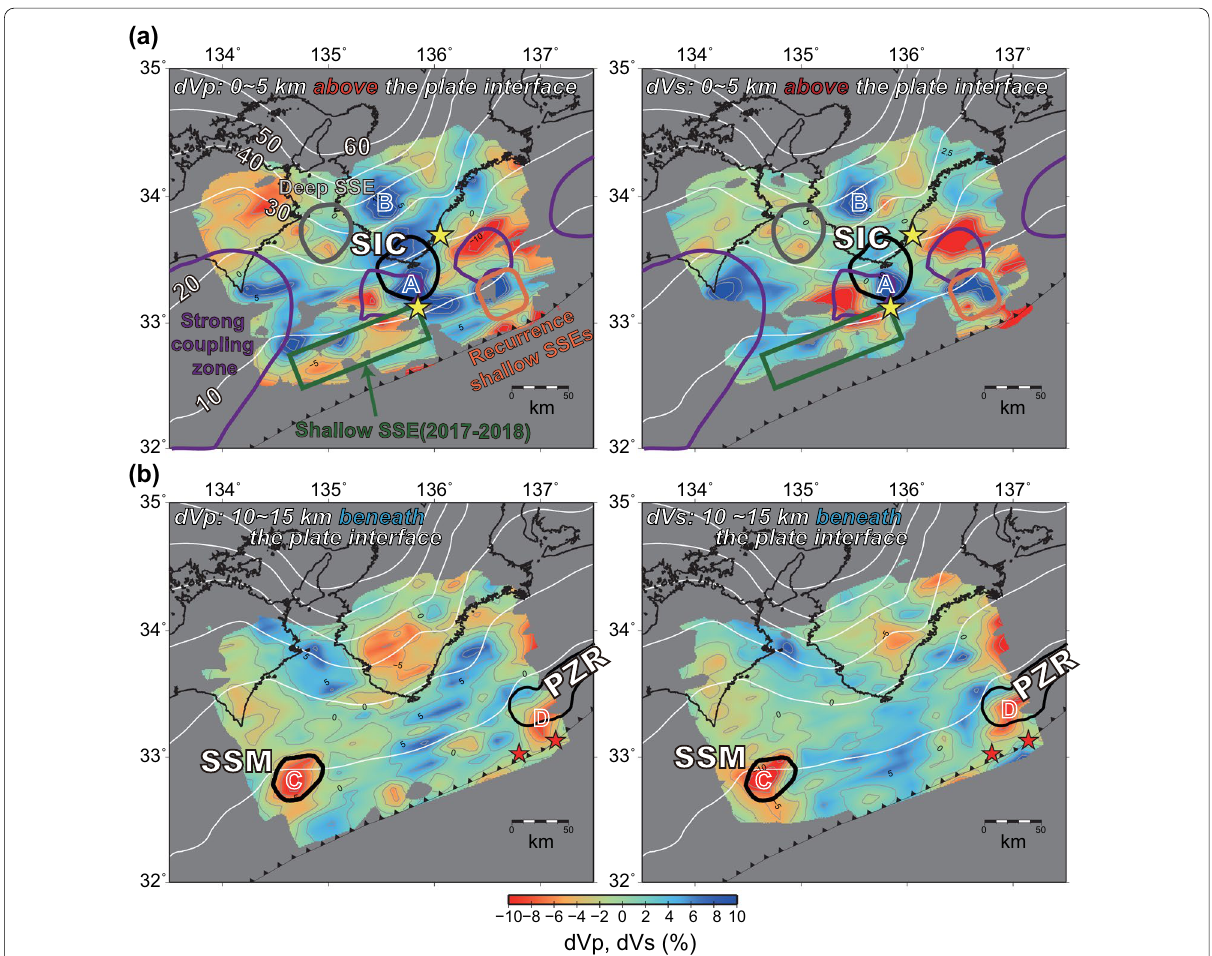
Fig. 9 Velocity perturbation within the 5-km-thick layer. a At just above the plate interface and b between 10 and 15 km below the plate interface. White contours are depth to the plate boundary (Nakanishi et al. 2018). Dashed contours reflect velocity differences from increments. The areas of strong (> 5 cm/year) interplate coupling estimated from onshore and offshore geodetic data are outlined by purple lines (Yokota et al. 2016). Areas outlined by gray, green, and orange lines reflect the fault location of deep SSE beneath the Kii channel (Kobayashi 2014), shallow SSE between 2017 and 2018 (Yokota and Ishikawa 2020), and recurrence shallow SSE (Araki et al. 2017; Ariyoshi et al. 2021), respectively. A, B, C, and D are the locations of substantial velocity anomalies discussed in the main text. Other symbols are the same as in Fig.